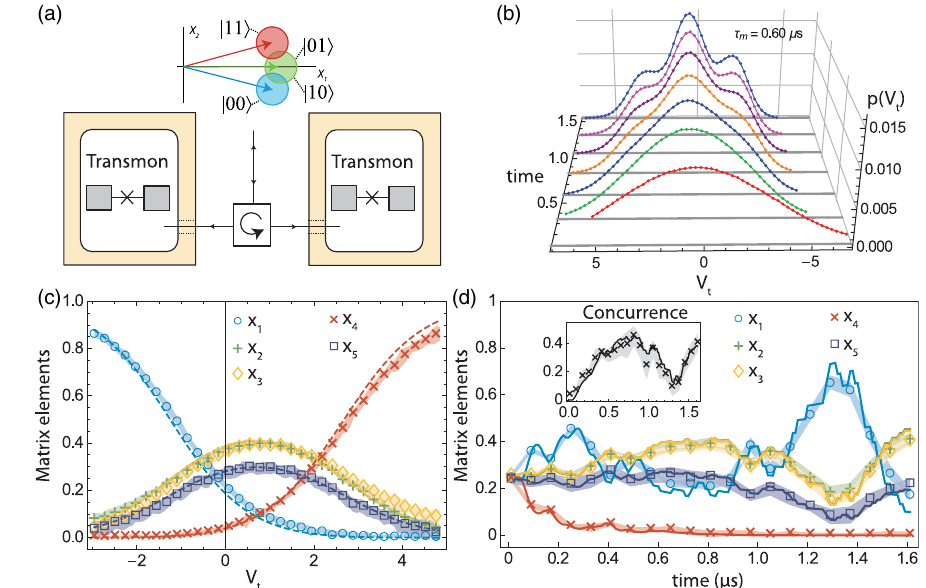
FIG. 1. Experimental setup and transmon qubit trajectories. Panel (a) shows a simplified illustration of the experimental setup. Two transmon qubits in two remote cavities are linked via a single microwave circulator in a bounce-bounce geometry; the output of the circulator is routed to a high-efficiency amplification chain (not shown). The upper inset represents the distribution of the microwave field in the ( X 1 , X 2 ) quadrature plane at the output of the amplifier. The three possible outcomes correspond to three different subspaces: j 00 i , j 11 i , and the odd-parity subspace (spanned by the j 01 i and j 10 i states). Panel (b) shows the evolution in time of the measurement outcome probability distribution p ð V . Panel (c) shows the agreement between the experimentally generated conditional tomography t Þ x V (symbols and shaded error bars) and the theoretical Bayesian reconstruction (dashed lines), for a single time t ¼ 0 . 48 μ s. In panel i ð t Þ (d), we use such reconstructions to predict and verify the trajectory of a single iteration of the experiment, showing both density matrix elements x and concurrence i